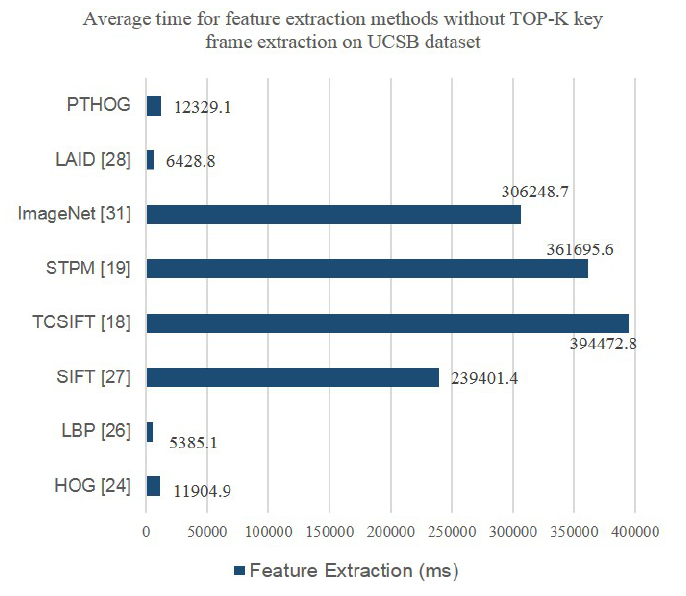
Figure 6. Average time for feature extraction methods without TOP-K key frame extraction on UCSB dataset.